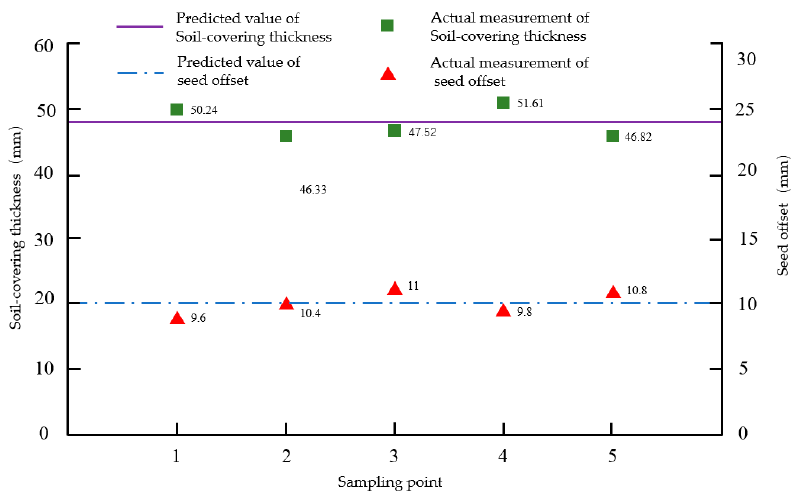
Figure 15. Test verification